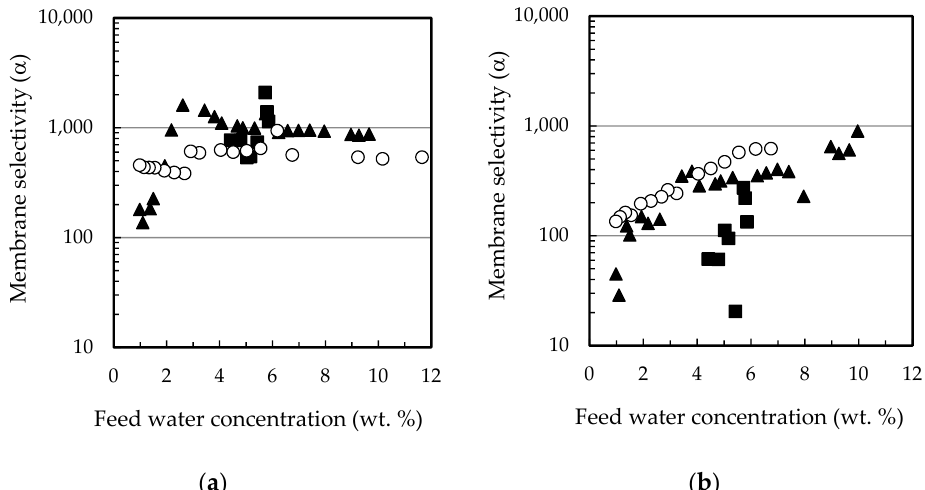
Figure 10. Membrane selectivity as a function of feed water content for the PERVAP TM 1131 mem ‐ brane at different temperatures: ( a ) water/ethanol, ( b ) water/ethyl lactate. ( ) T = 80 °C, ( ) T = 60 °C, ( ) T = 40 °C. Initial feed content: 13.5% lactic acid, 17.7% ethyl lactate, 10% water and 58.8% ethanol.